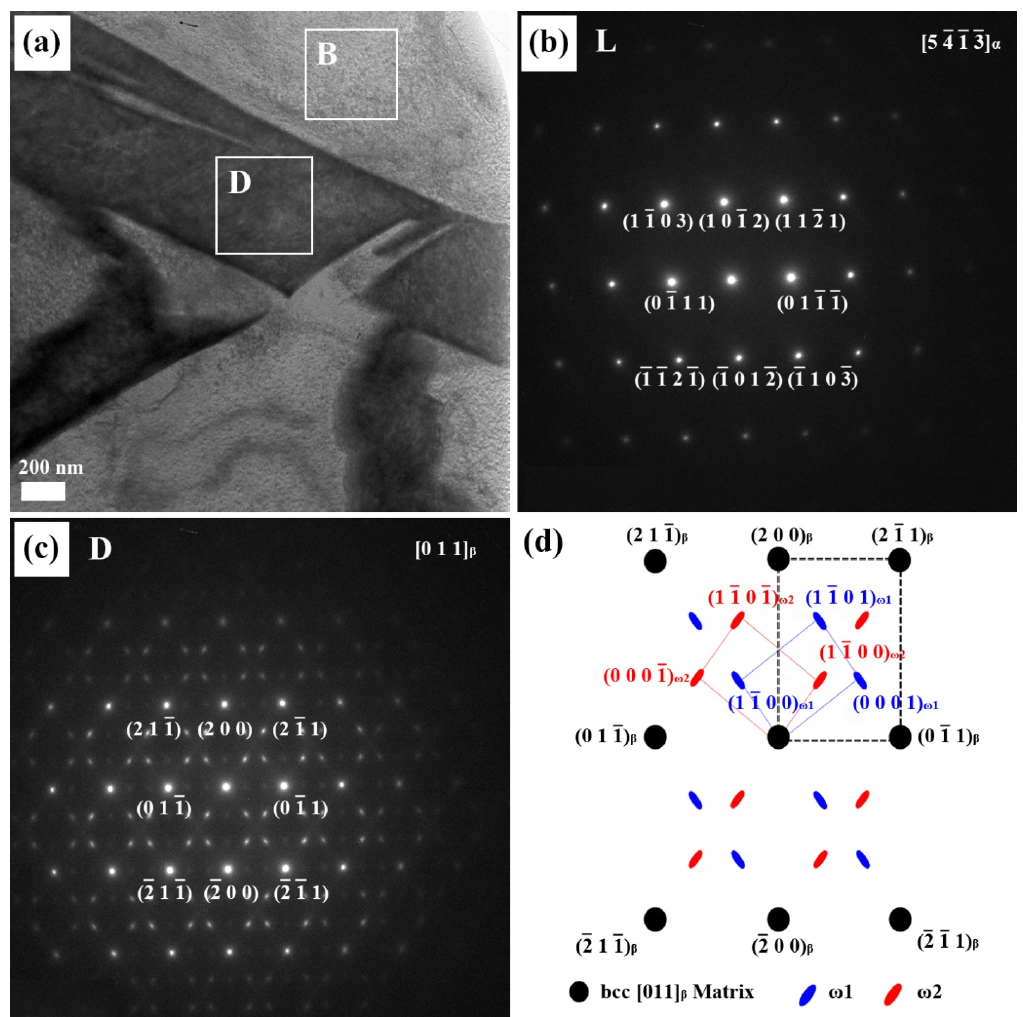
Figure 3. ( a ) The bright-field TEM image of the Ti-10Nb alloy; ( b ) the corresponding selected-area electron diffraction (SAED) patterns from the bright area (B); ( c ) the SAED patterns from the dark area (D); and ( d ) the key diagram of ( c ).